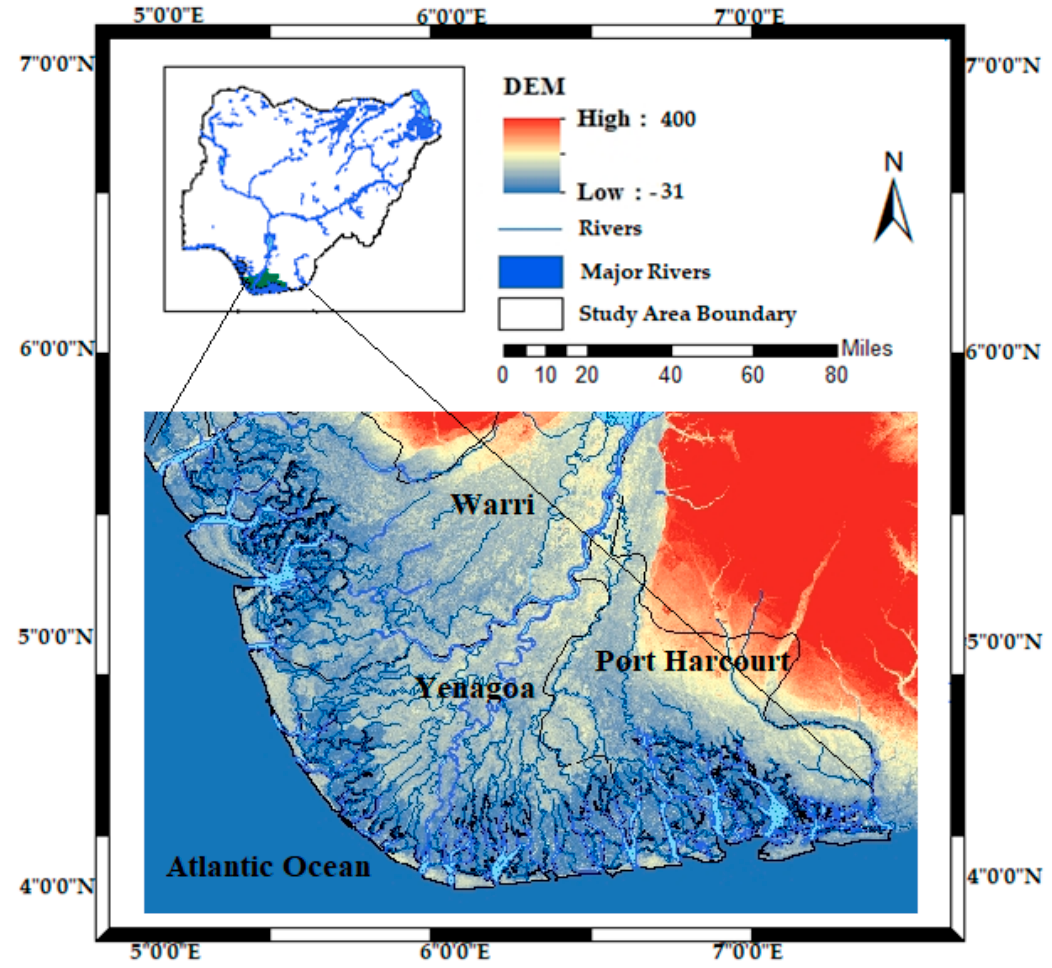
Figure 1. Location of the study area in Nigeria.